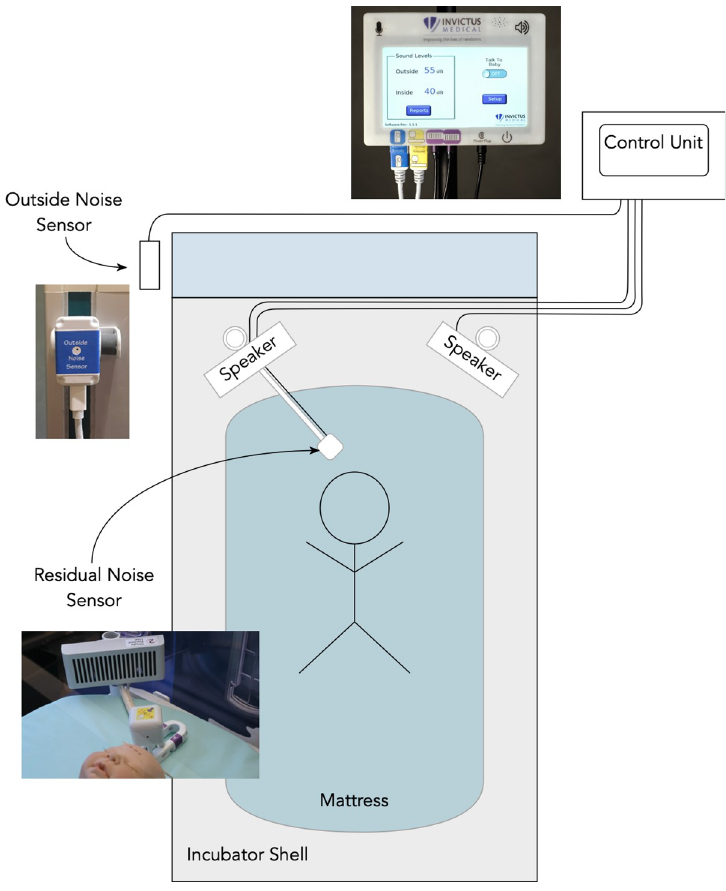
Fig 1. Schematic of the Neoasis ™ elements. The Neoasis ™ comprises a residual noise sensor, two speakers positioned inside the incubator, an outside noise sensor affixed to the outside of the incubator, and a control unit to which the other items are